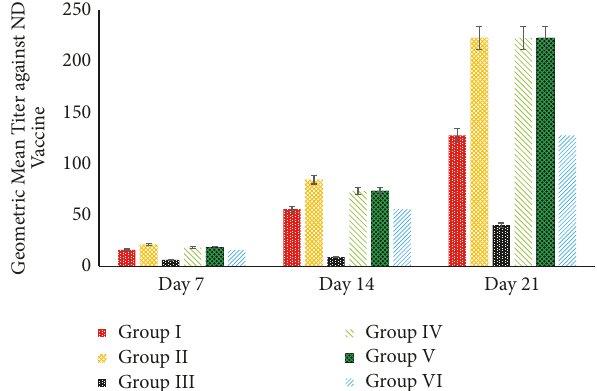
Figure3:Effectof5%SAPonthegeometricmeantiter(GMT)value against ND vaccine in the broiler chicken fed a diet with naturally contaminated with